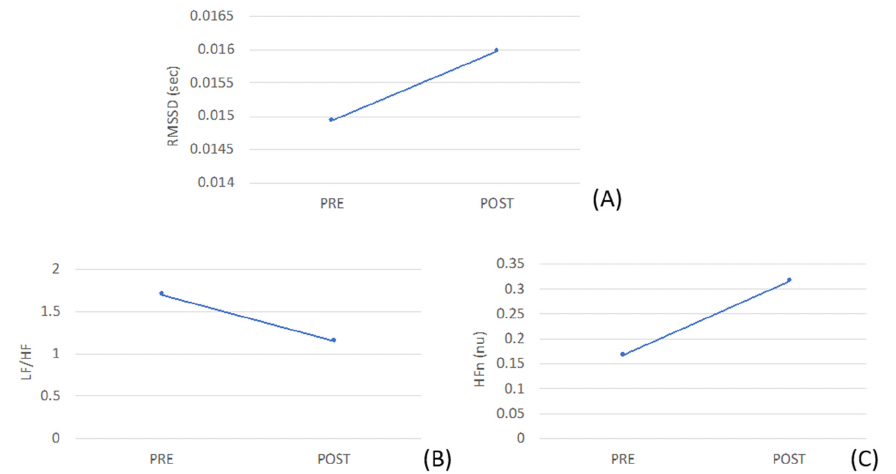
Figure 4. Trend of the features extracted from the R-R series: ( A ) Root Mean Square of the Successive Di ff erences of the R-R signal (RMSSD), ( B ) LF / HF ratio, ( C ) normalized High Frequency component of the ECG signal.